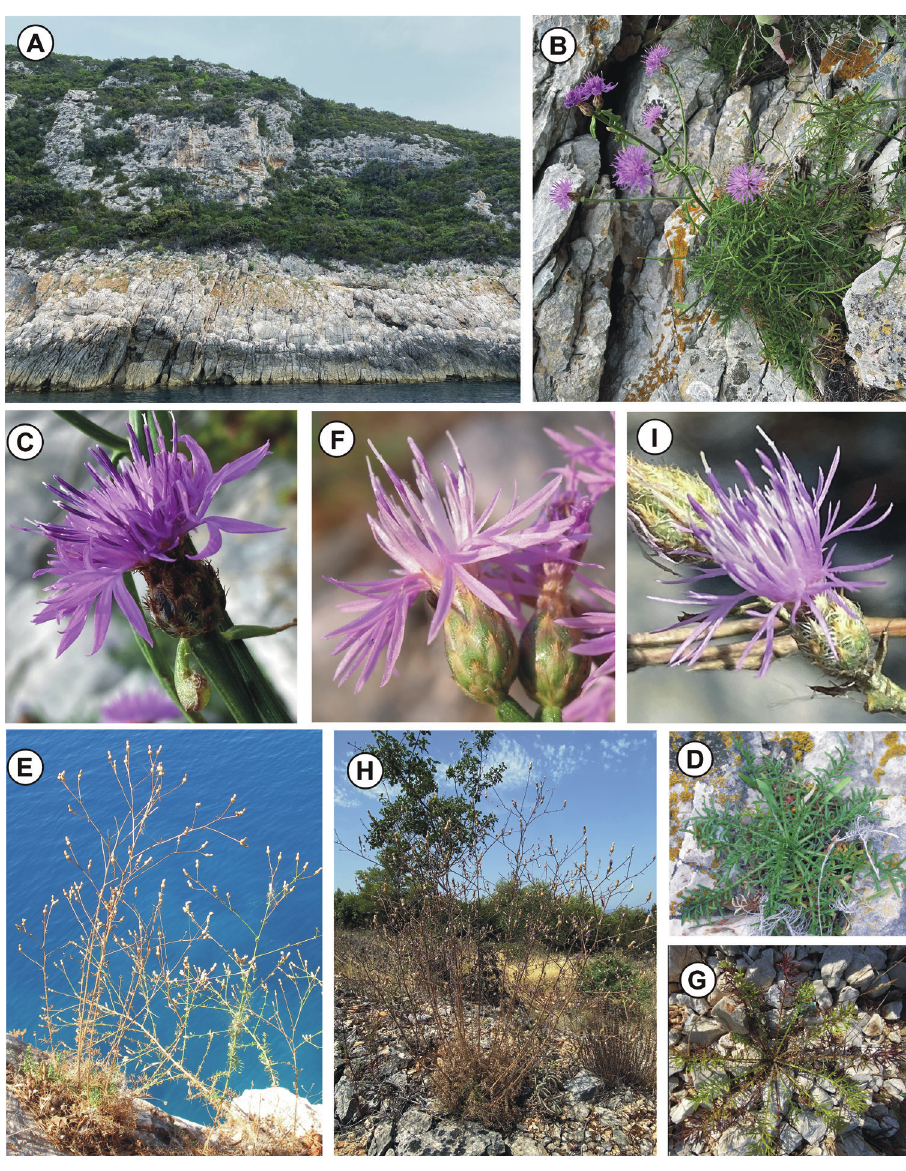
Figure 3. Centaurea lovricii sp. nov. A habitat B plant growing in natural habitat C capitulum D basal leaves; C. glaberrima E plant growing in natural habitat F capitula G basal leaves; C. divergens H plant growing in natural habitat I capitulum. Photographed by Sandro Bogdanović.